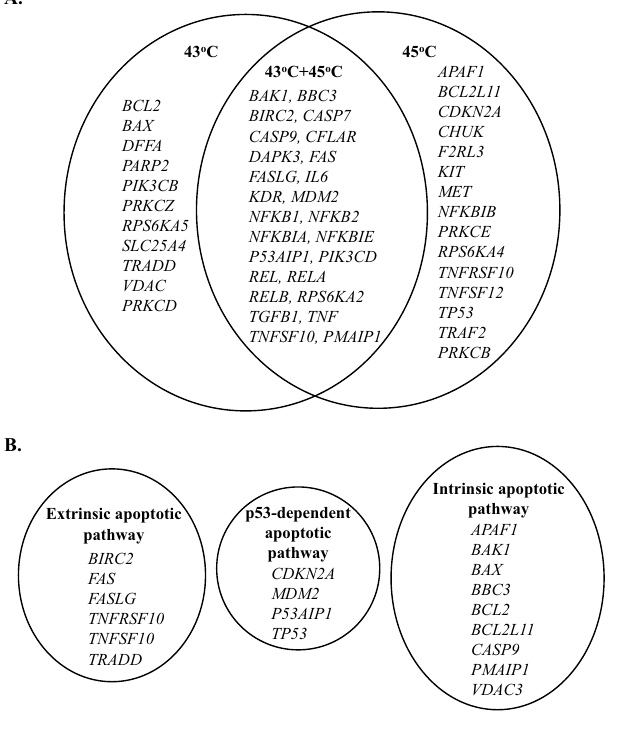
Figure 3. Apoptotic gene profiling by RT-PCR-based microarrays. A list of apoptotic genes categorized according to ( A ) hyperthermic exposure condition and ( B ) key apoptotic pathway